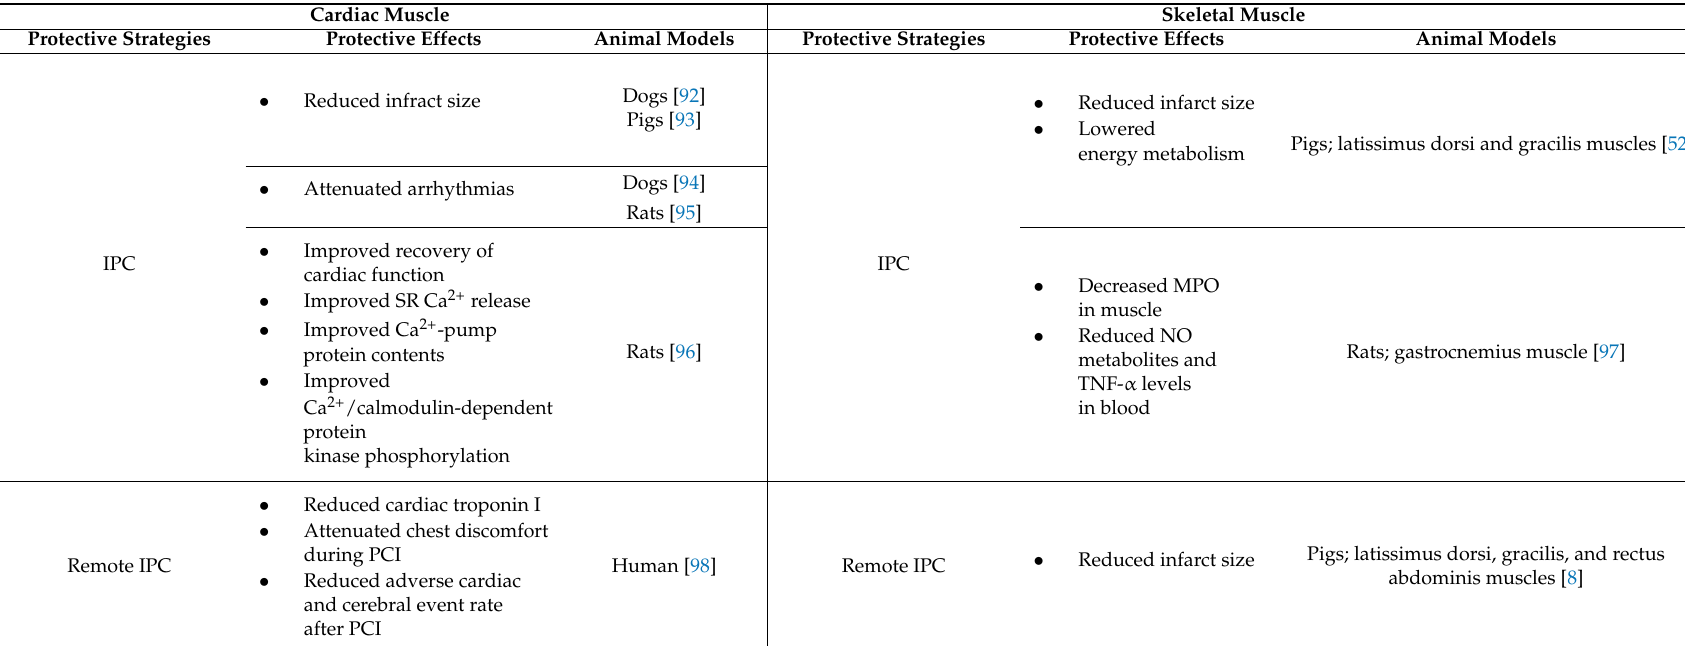
Table 2. Protective strategies against IR-induced injury in cardiac and skeletal